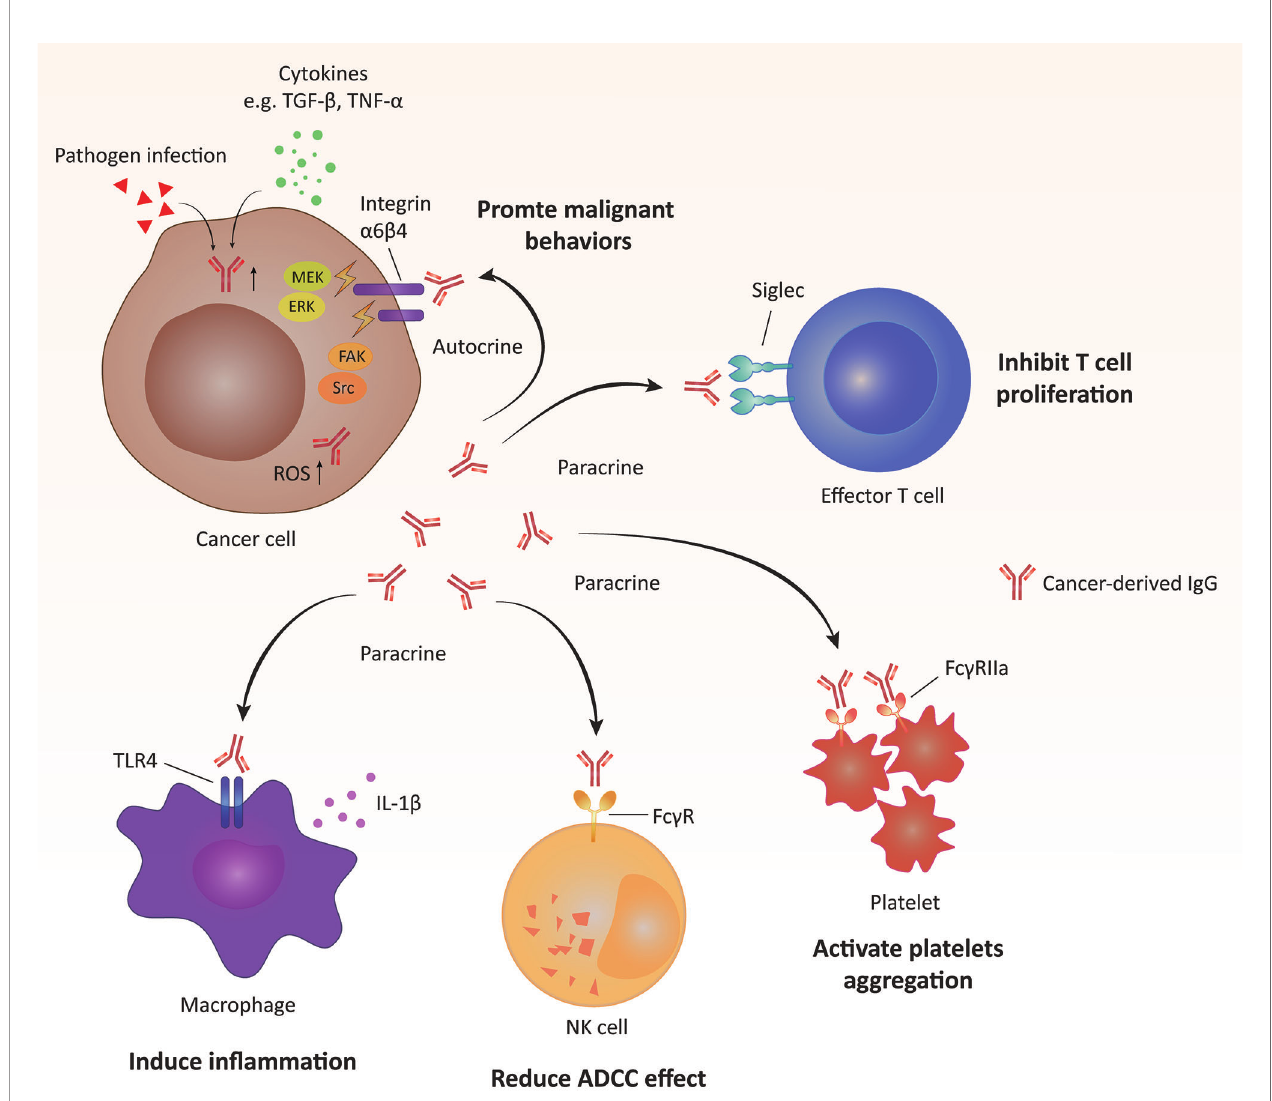
FIGURE 1 | Molecular mechanisms of action of cancer-derived IgG. Cancer-derived IgG promotes tumorigenesis in autocrine and paracrine manners.(i) Cancer- derived IgG interacts with integrins located on the tumor cell membrane and then activates downstream pathways, including FAK/Src, MEK/ERK/c-Myc and reactive oxygen species (ROS) pathways. (ii) Cancer-derived IgG interacts with different membrane receptors of other types of cells, including Siglec of T cells, Toll-like receptor (TLR) of macrophages and Fc g R of natural killer (NK) cells and platelets, and further regulates the functions of these cell types. ADCC, antibody-dependent cellular